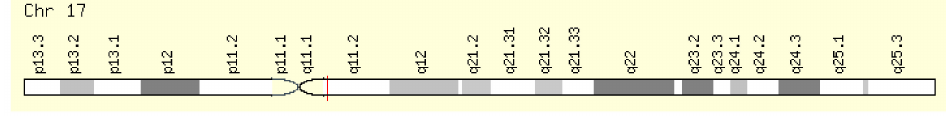
Figure 5. Localization of the NOS2 gene [7].